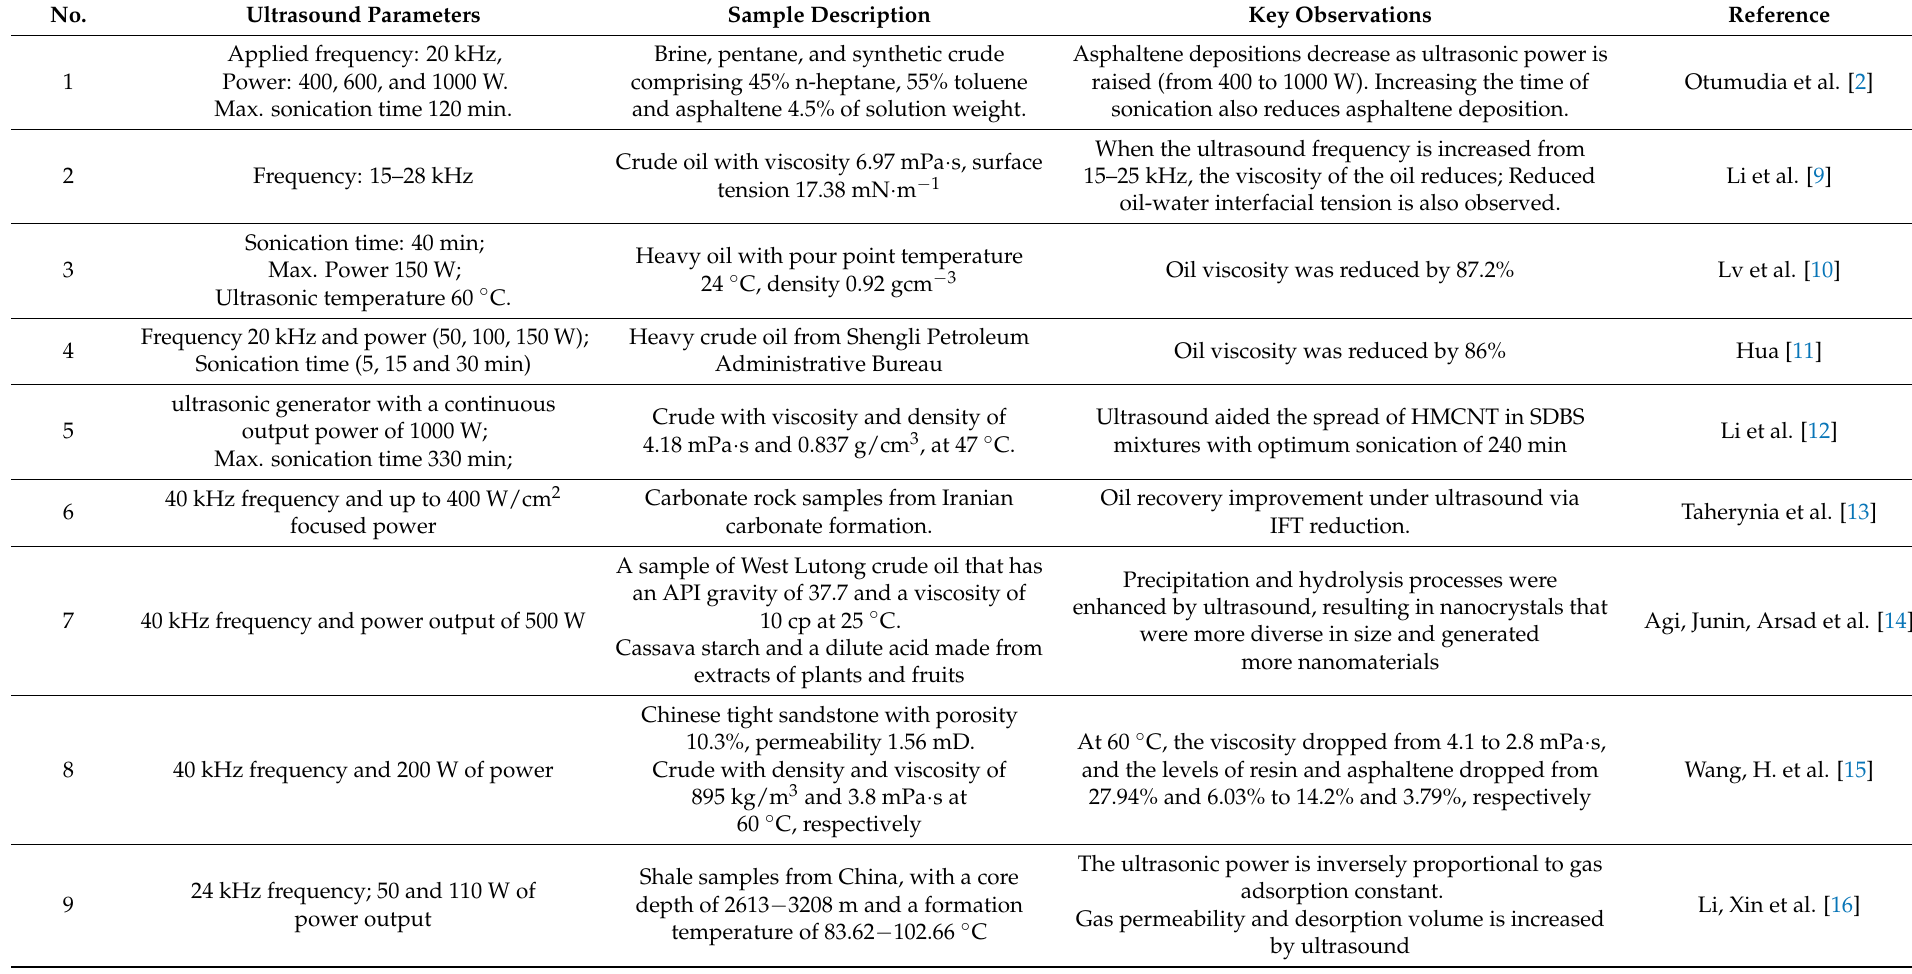
Table 1. Summary of current investigations of ultrasonic waves in petroleum